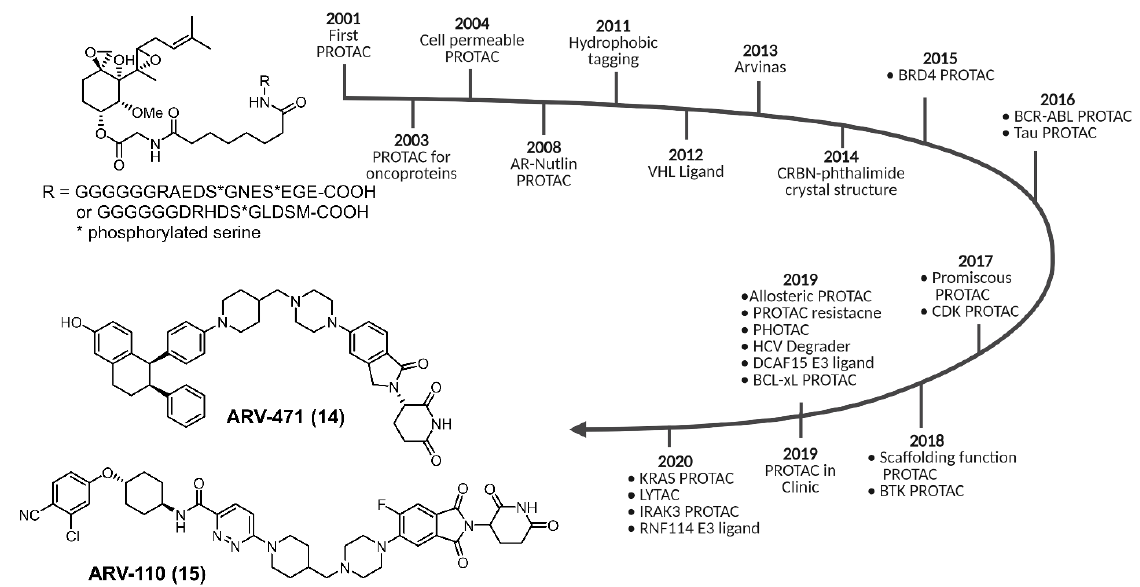
Figure 3. PROTACs evolution from bench to bedside (created with BioRender.com).